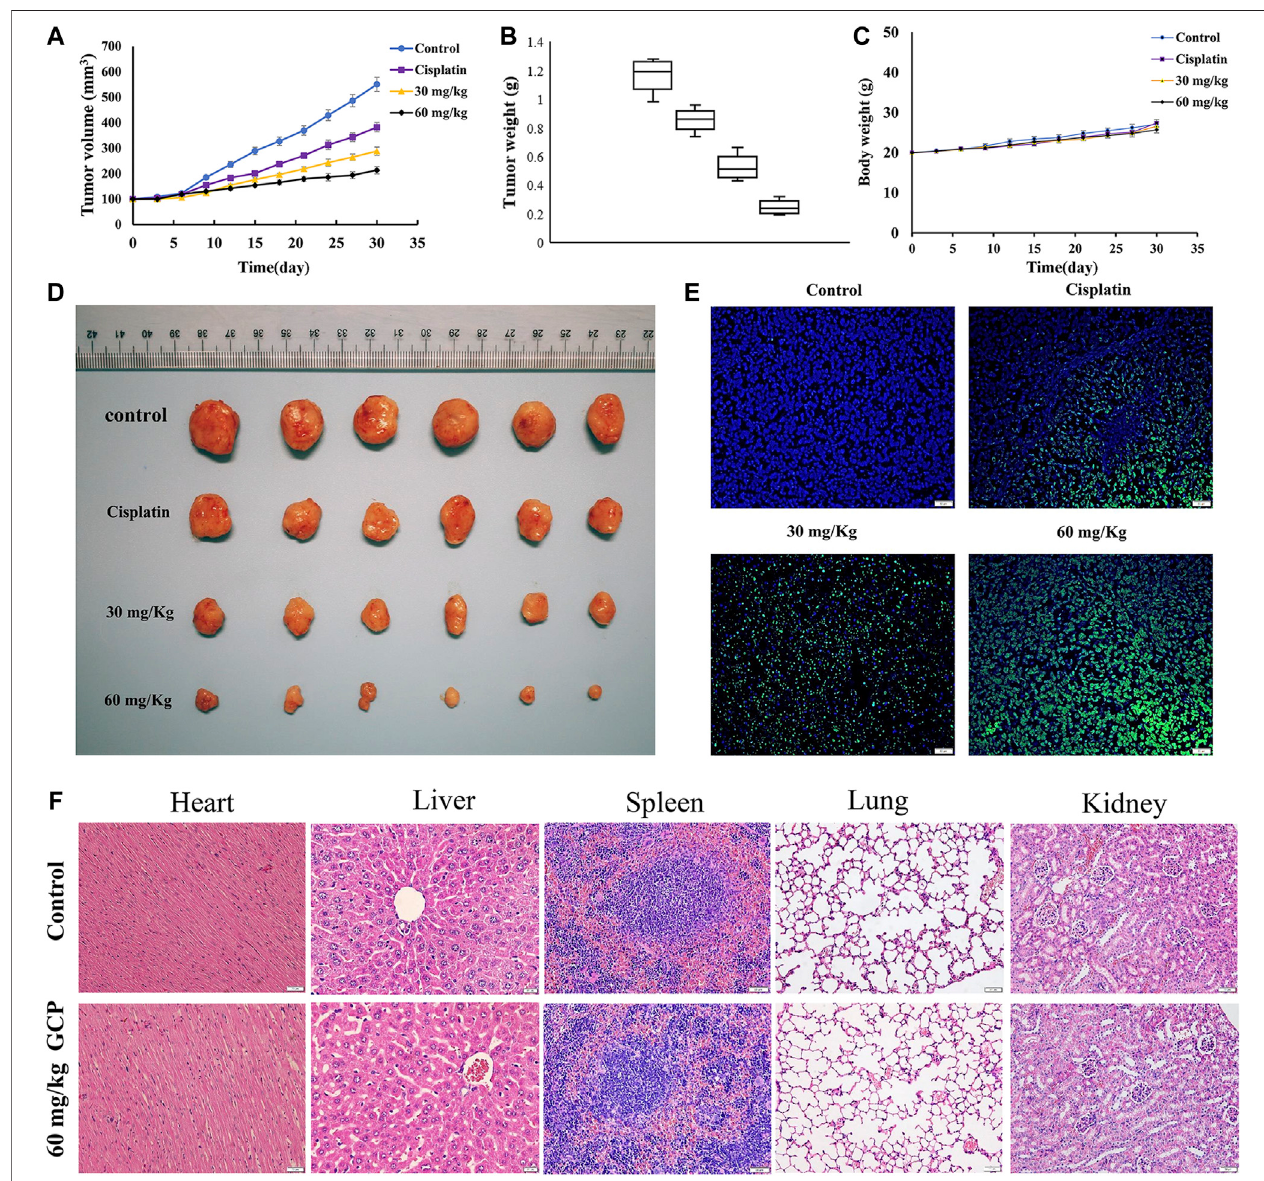
FIGURE 8 | GCP inhibits tumor growth in vivo . (A) Tumor growth curves (B) tumor weight (C) and mouse body weights in four groups (control group; cisplatin group;30 mg/kgGCPgroup;60 mg/kgGCPgroup). (D) Imageoftumorsfrommiceofeachgroup. (E) TumortissueswerestainedusingTUNELmethod,andthegreen area is TUNEL-positive cells (Magni fi cation bars, 20 μ m). (F) HE staining of heart, liver, spleen, lung, kidney in control and 60 mg/kg GCP group (Magni fi cation bars, 20 μ m).